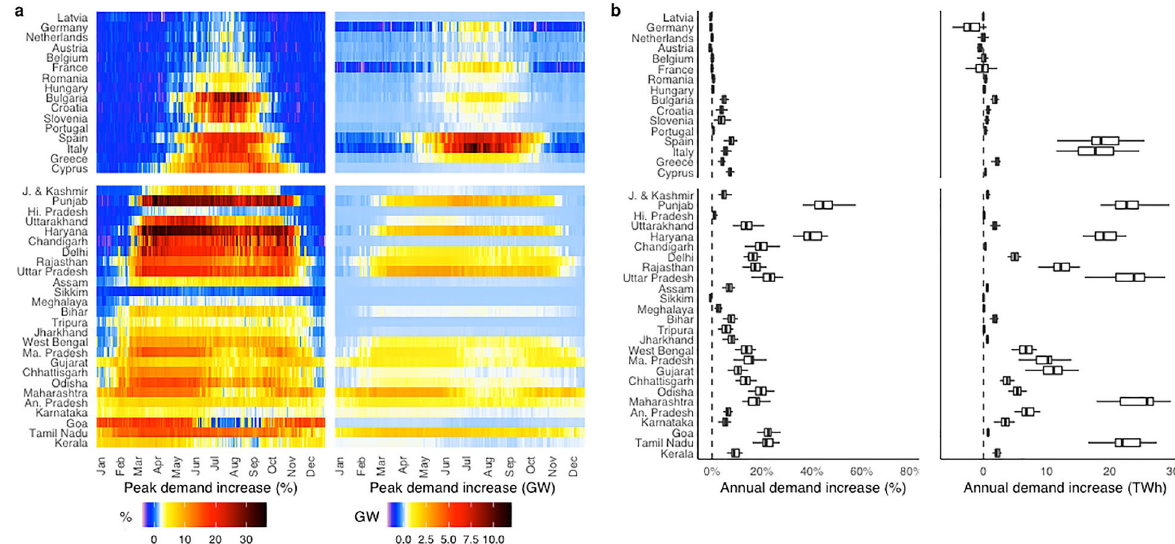
Figure 3. Amplification of peak and total load circa 2050. ( A ) Relative increase in the daily peak load, median of 29 GCMs (left) and absolute increase in the daily peak load, median of 29 GCMs (right) circa 2050.